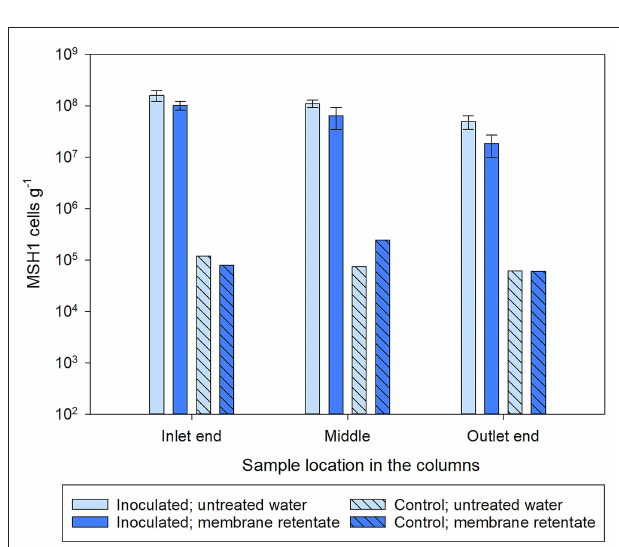
FIGURE 4 | Number of Aminobacter sp. MSH1 cells based on the quantification of bbdA genes detected in the sand sampled from different locations within the columns at experimental termination. Columns received during operation a feed of either untreated water with 0.3 µ g l − 1 BAM (light blue bars) or membrane retentate water with 3.0 µ g l − 1 BAM (dark blue bars). For the columns inoculated with Aminobacter sp. MSH1 data are presented as means ( n = 3) with error bars showing standard error. Two control columns were run without initial inoculation (hatched bars; n = 1).